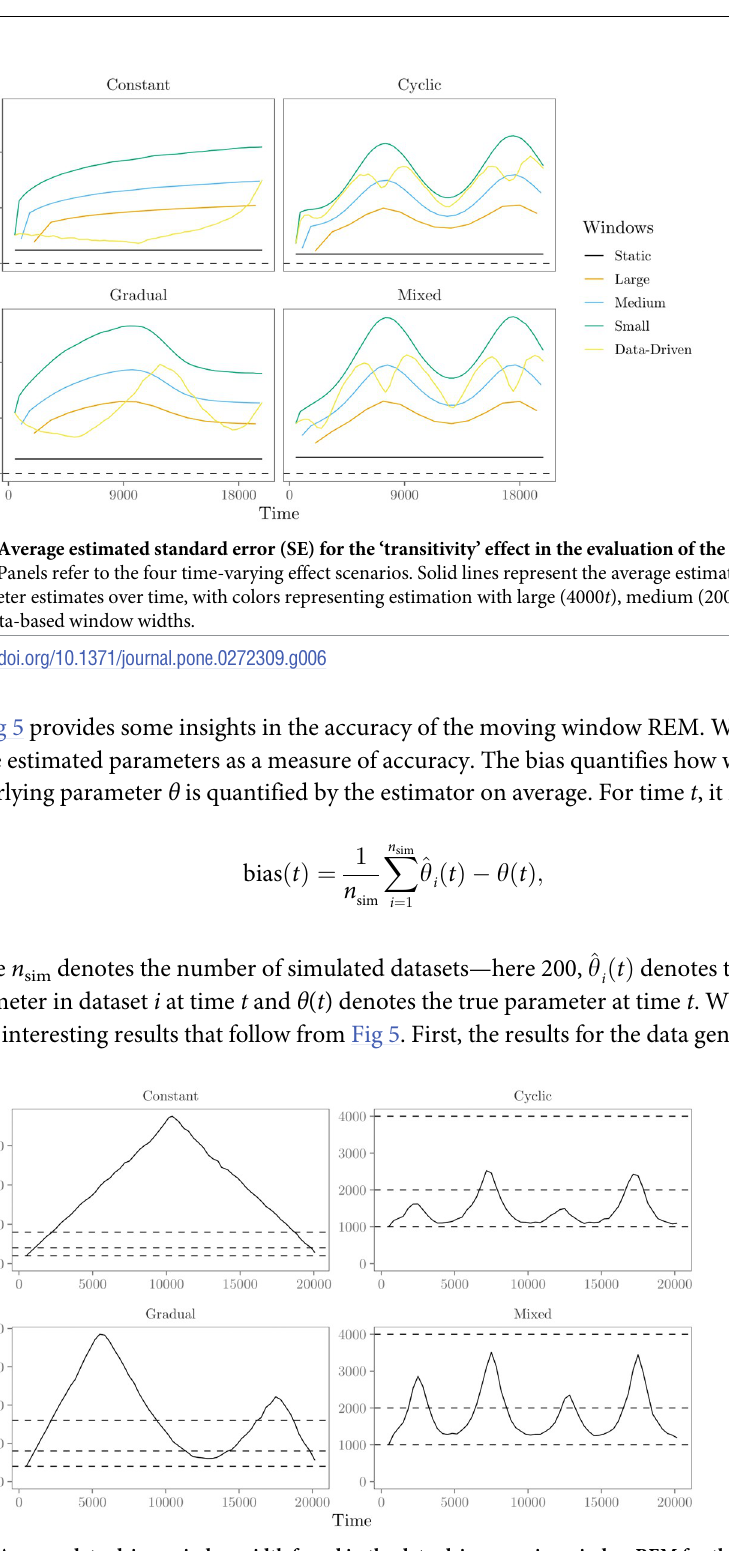
Fig 7. Average data-driven window width found in the data-driven moving window REM for the four time- varying effect scenarios. Horizontal dashed lines refer to the different fixed window widths evaluated for the moving window REM, i.e., large (4000 t ), medium (2000 t ), small (1000 t ).